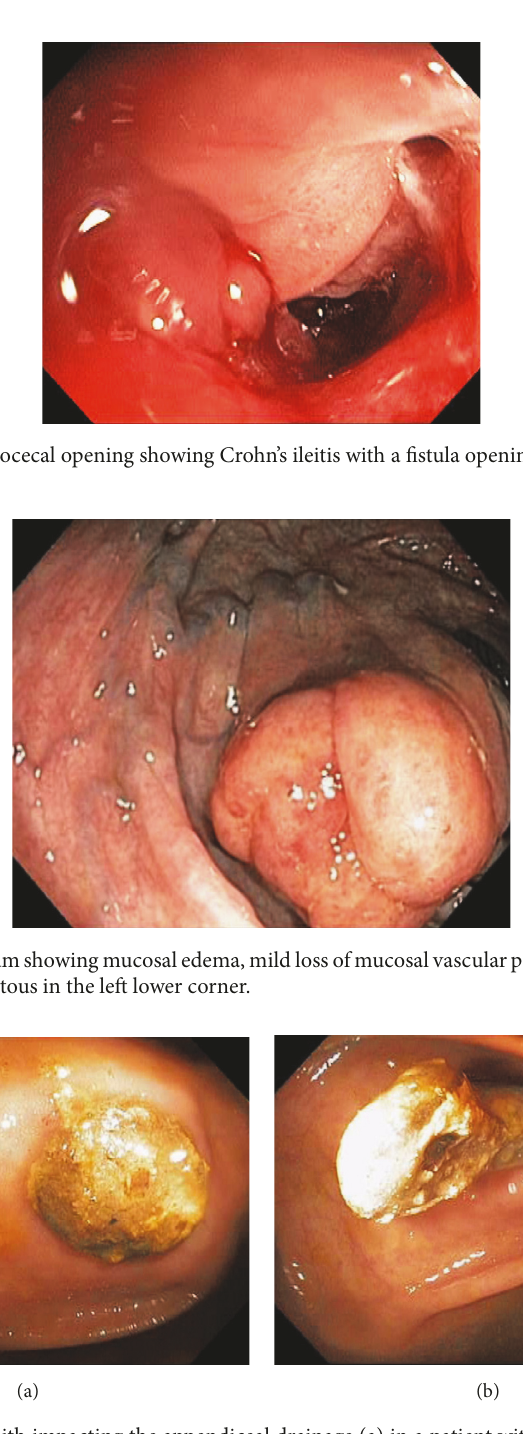
Figure 23: Endoscopic images of a fecalith impacting the appendiceal drainage (a) in a patient with recurrent right lower abdominal pain. Endoscopic disimpaction of fecalith can be attempted